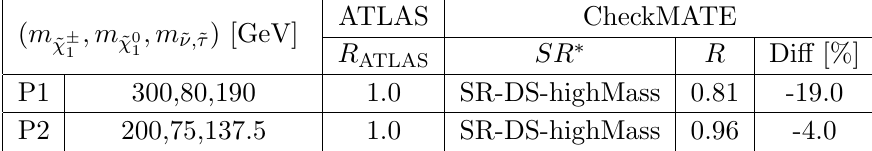
Table 5 . Similar to table 4, but for the ~ (cid:31) (cid:6) results plotted in (cid:12)gure 7b of [125].